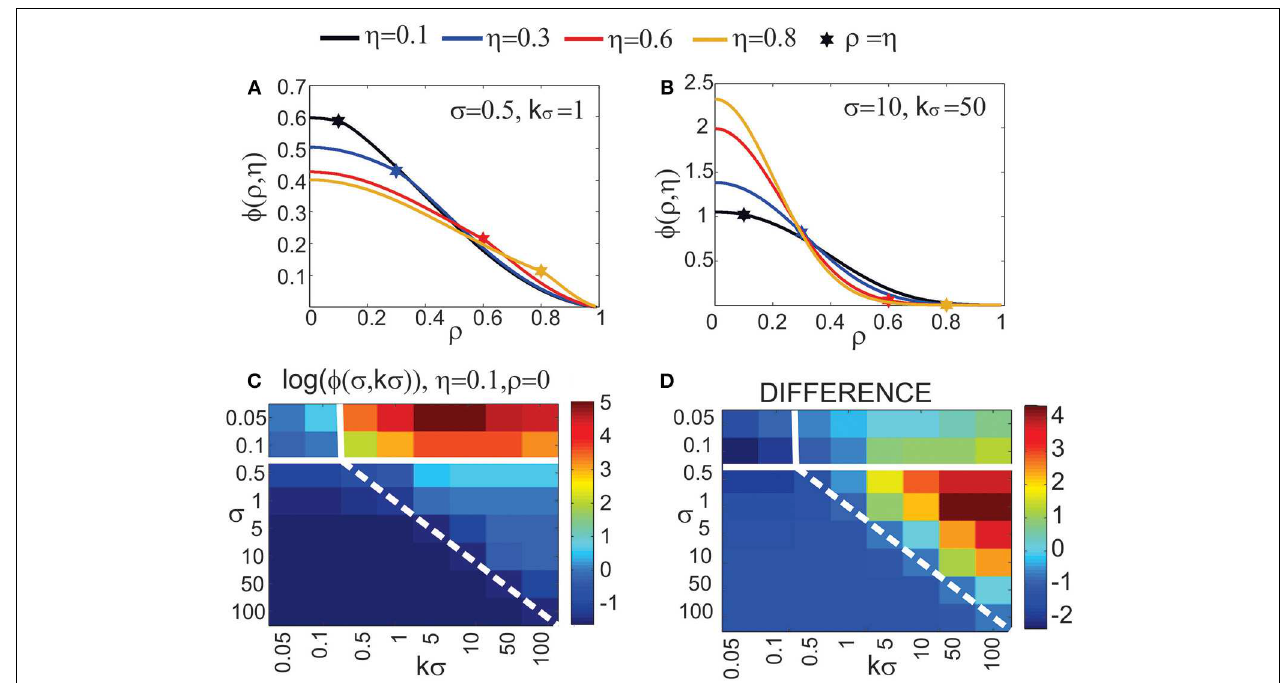
FIGURE 5 | Top row: Additional analysis of the distance-dependent η 0 . 8 and for η 0 . 1 . Bars on the right of the panels show the color code. = = The values for σ and k σ are given on the y and x axis, respectively. The white expected number of synapses [ φ ( ρ,η, M ) ] . The point where ρ η is marked = lines on the panels divide the parameter space ( σ, k σ ) according to the shape with a star. (A) Truncated Gaussian distribution of neurites with parameters of the obtained function φ ( ρ,η, M ) . The upper left area and the lower right σ 0 . 5 and k σ 1 (repeated example from Figure 4B ). (B) Truncated = = triangular area give functions between step-functions and bell-shaped Gaussian distribution of neurites with parameters σ 10 , k σ 50 (repeated = = curves, as in (B) . The upper right area gives narrow bell-shaped functions like example from Figure 4C ). Bottom row: Maximal values of the the ones from Figure 4D . The lower left area corresponds to functions distance-dependent expected number of synapses, obtained for ρ 0 . (C) = similar to the case of neurites with uniform distribution, shown in (A) . The shows the logarithm of the maximal values obtained for η 0 . 1 , ρ 0 and a = = dashed white line indicates a slow transition of the function shape between wide range of values for σ and k σ . (D) illustrates the range of values for the the two logarithm of the function maxima, i.e., the difference between log (φ) for